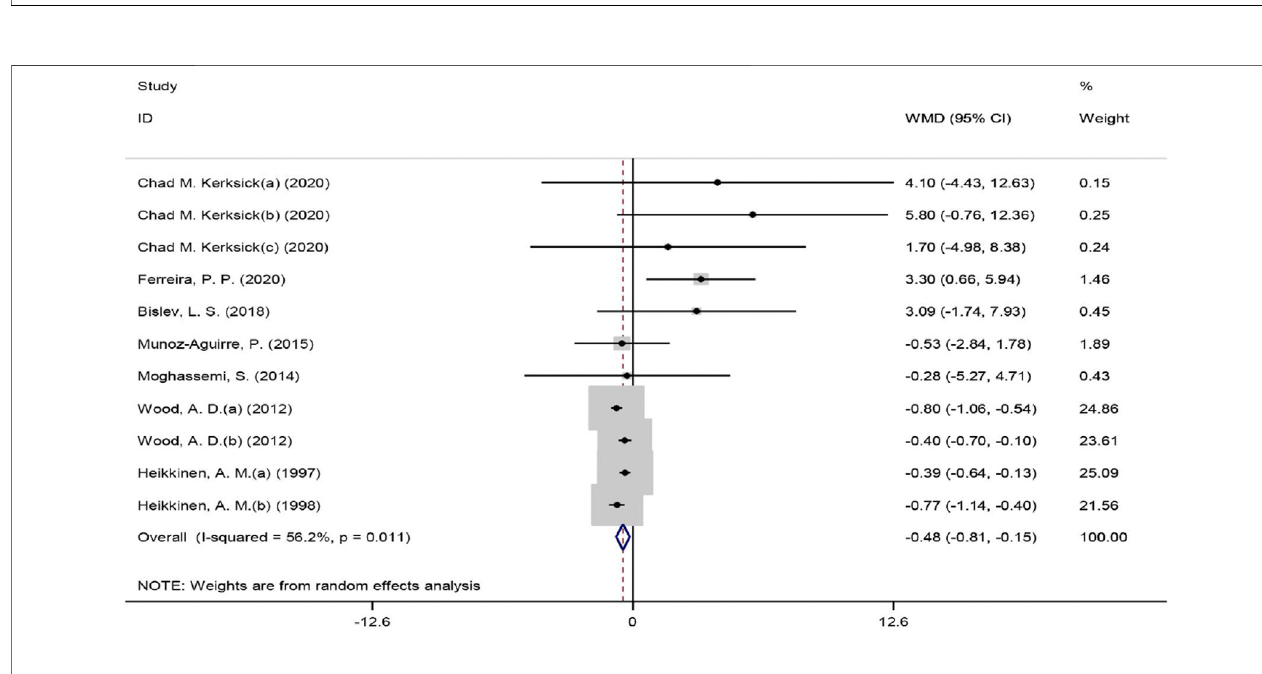
FIGURE 3 | Forest plot of the randomized controlled trials investigating the effects of vitamin D administration on HDL-C.